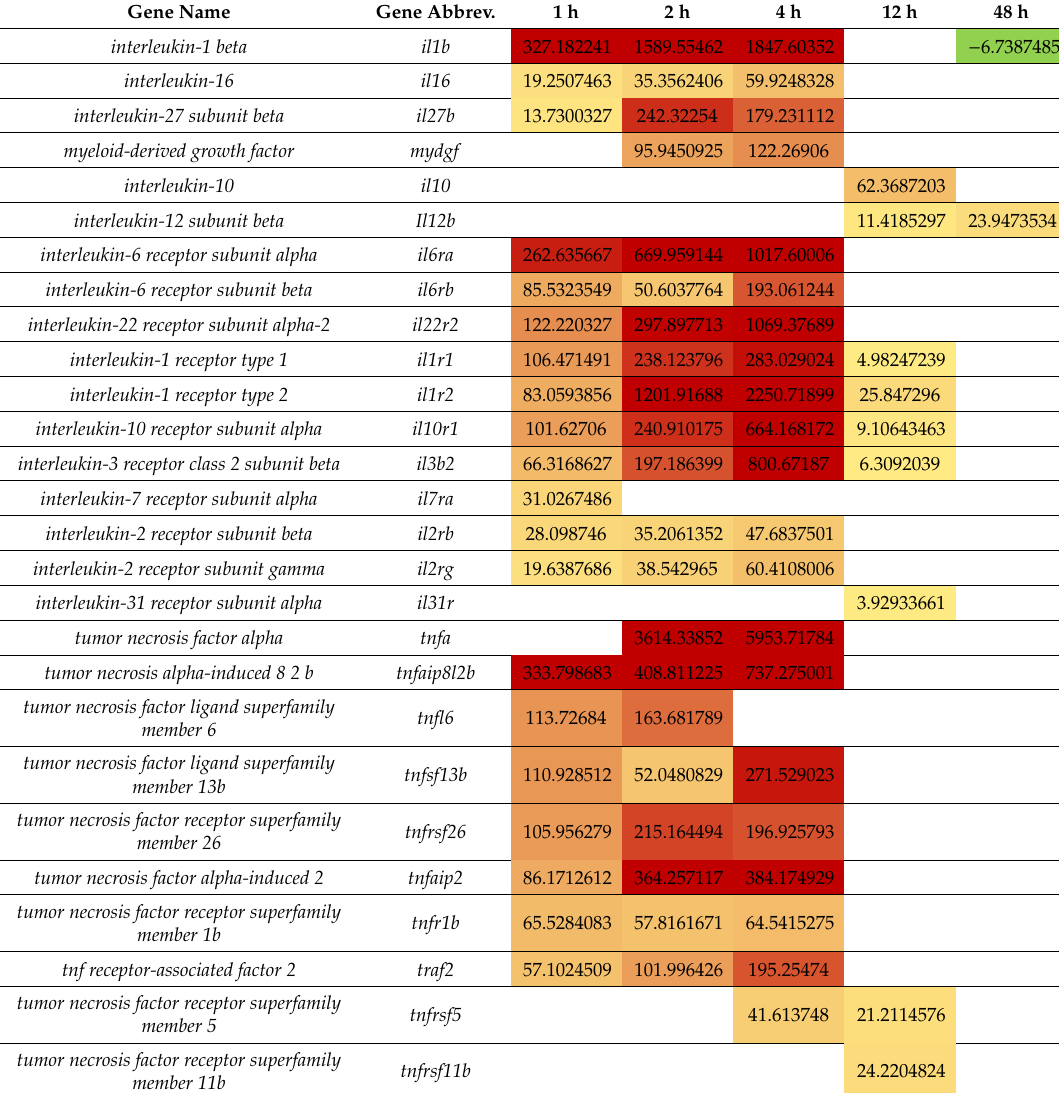
Table 5. Heat map showing a group of DE genes in turbot peritoneal cells at 1, 2, 4, 12 and 48 hpi, including genes coding for interleukins, interleukin receptors, genes of the tumour necrosis factor (TNF) family and genes involved in di ff erent signalling pathways. Results are expressed as mean expression ratios of groups 1, 2 and 4 hpi vs. 0 h, or 12 and 48 hpi vs. PBS. Red indicates increased gene expression levels; green indicates decreased